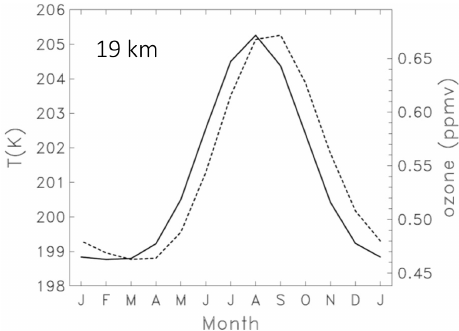
Figure 2. Climatological annual cycles of ozone (dashed line) and temperature (solid line) at 19km derived from SHADOZ measure- ments over